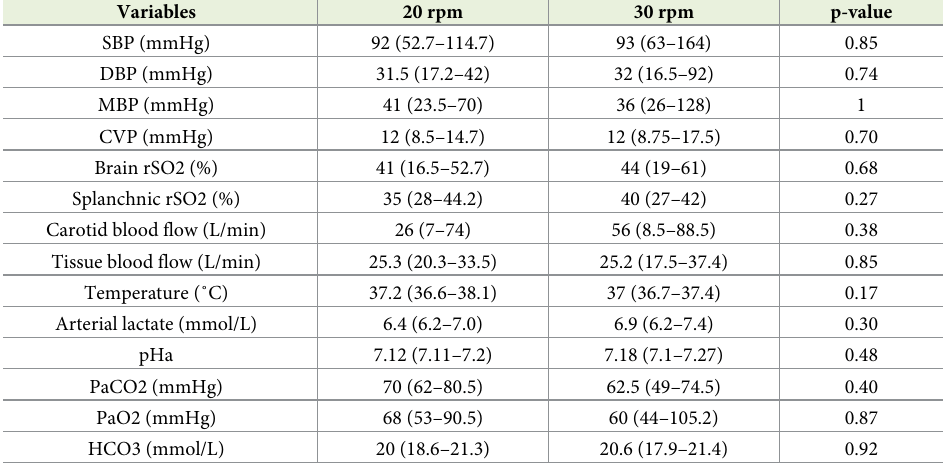
Table 1. Hemodynamic, perfusion and ventilation parameters immediately before ROSC. Comparison between groups.